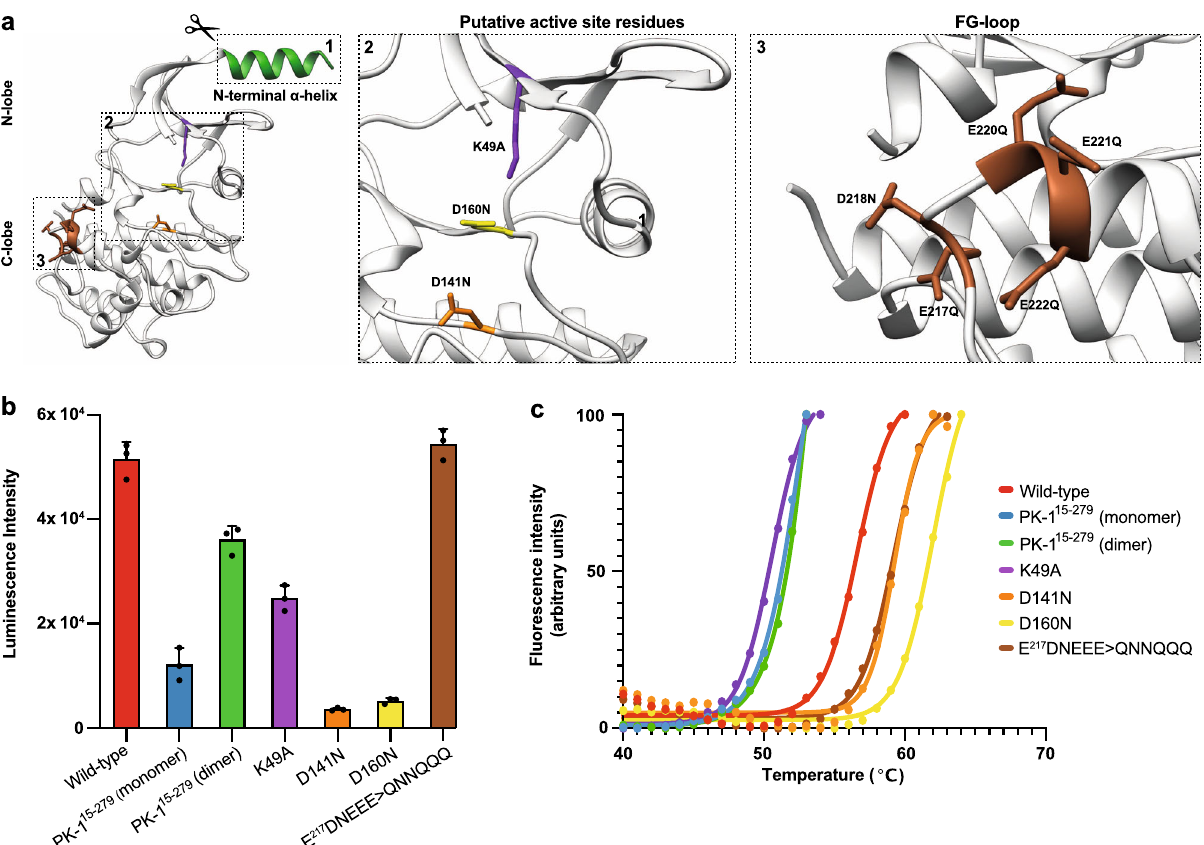
Fig. 4 Biochemical characterisation of PK-1. a Residues mutated in the present study are shown as sticks on the PK-1 crystal structure solved in this study (Fig. 1), including the truncated N-terminal α -helix (green ribbon) to generate PK-1 15 – 279 (box 1) and zoomed views of the putative active site residues (box 2) and the patch of acidic residues (brown sticks) within the α F- α G loop (box 3) shown on the right. b In vitro kinase activities of the PK-1 wild-type and mutant constructs. Individual data points are plotted; the bar and error bars shown represent mean ± SD of three independent ADP-Glo assays. c Thermal melt curves of the PK-1 wild-type and mutant constructs, performed using differential scanning fl uorimetry con fi rms that these variants are folded. Data represent mean of two independent experiments. Data are plotted throughout for wild-type PK-1 in red, and mutants are color-coded: truncated PK-1 monomer in blue and dimer in green; K49A, purple; D141N, orange; D160N, yellow; and E 217 DNEEE>QNNQQQ,